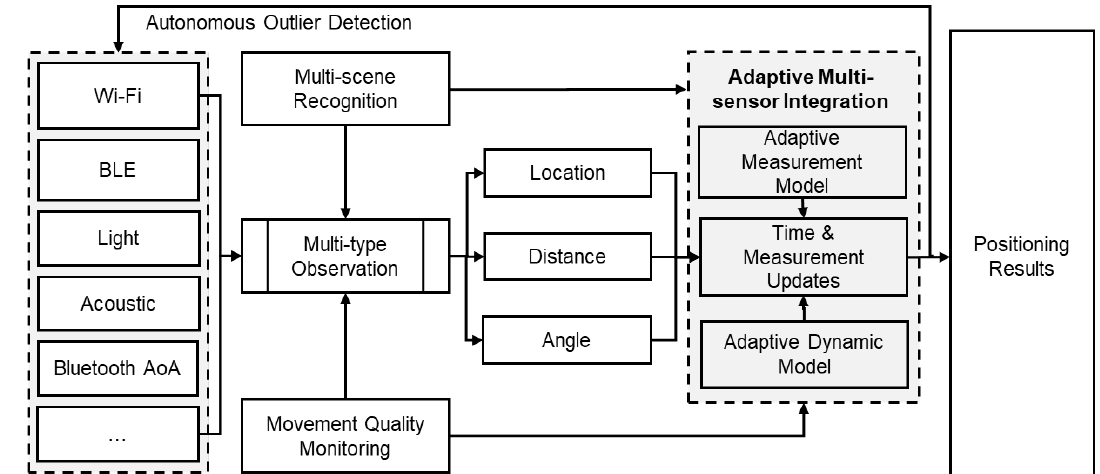
Figure 1. Flowchart of the adaptive multi-sensor integration